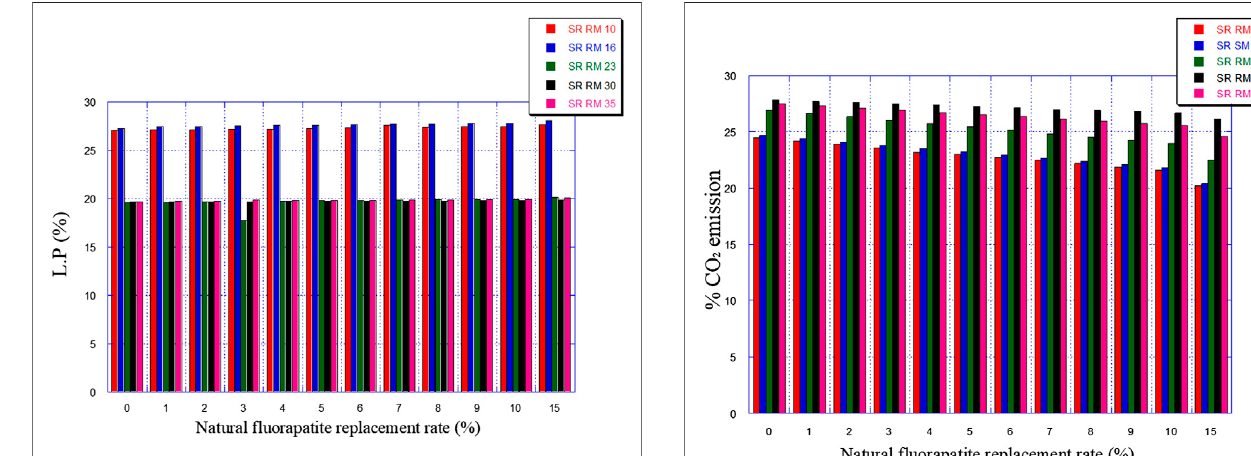
FIGURE 9 | Predicted liquid phase (L.P) amounts in function of the natural fl uorapatite replacement. FIGURE 10 | Expected CO